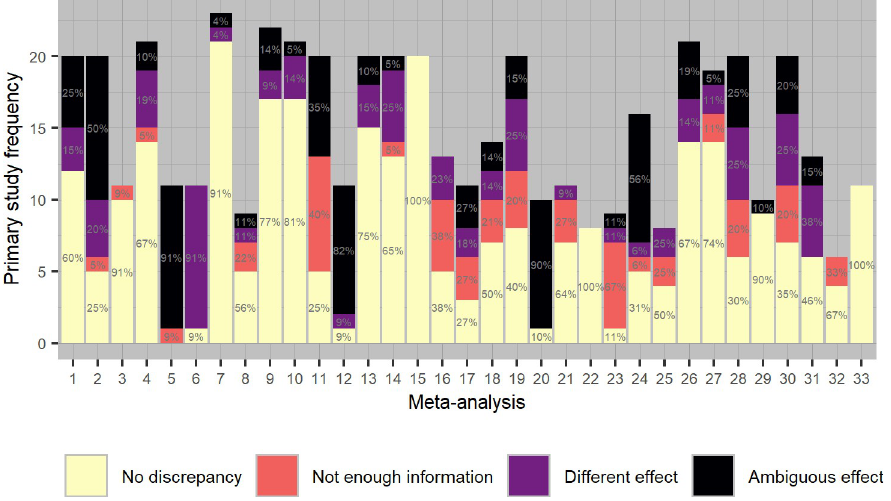
Fig 4. Frequencies of reproduced primary study effect sizes with and without errors, per